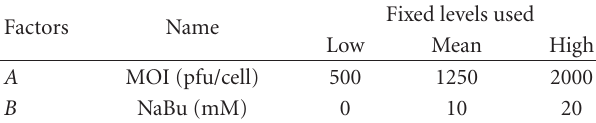
Table 2: Factors checked in toxicity test for H9c2 and their concentrations in factorial design experiment. The cells were treated with the components for 48 hrs before performing the toxicity